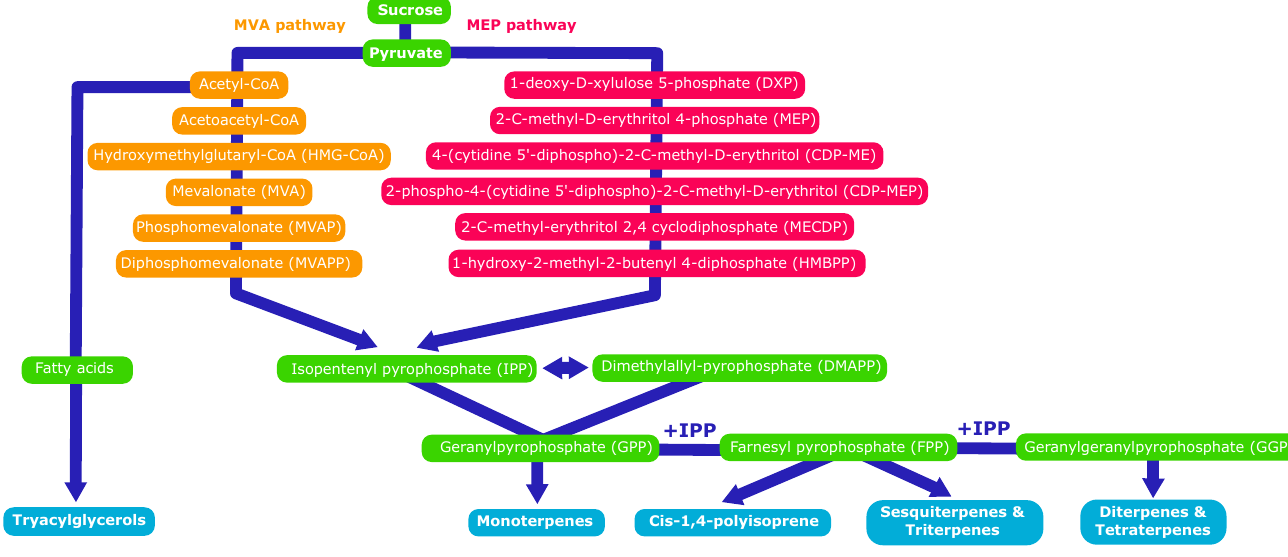
Figure 6. Biosynthesis of polyisoprene and resin